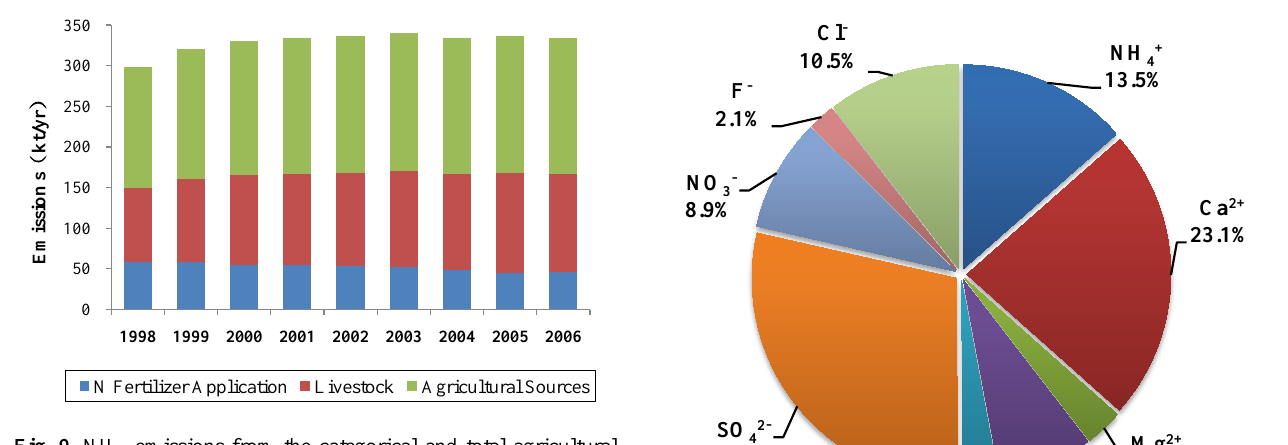
Fig. 9. NH 3 emissions from the categorical and total agricultural sources in the PRD region from 1998 to 2006.